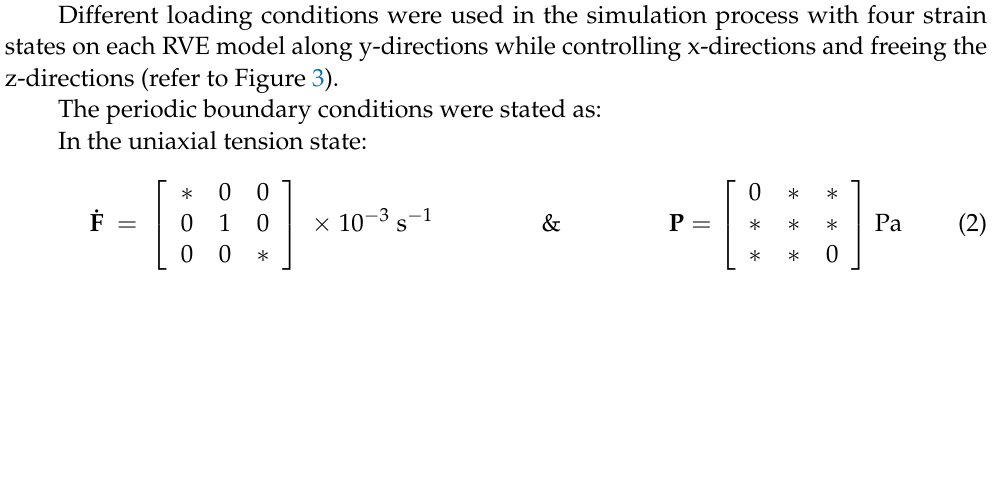
Table 3. Physical and fitting parameter values were adopted from the published literature for ferrite